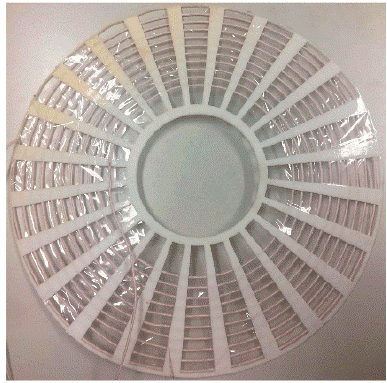
Figure 6. Photograph of the practical coil.